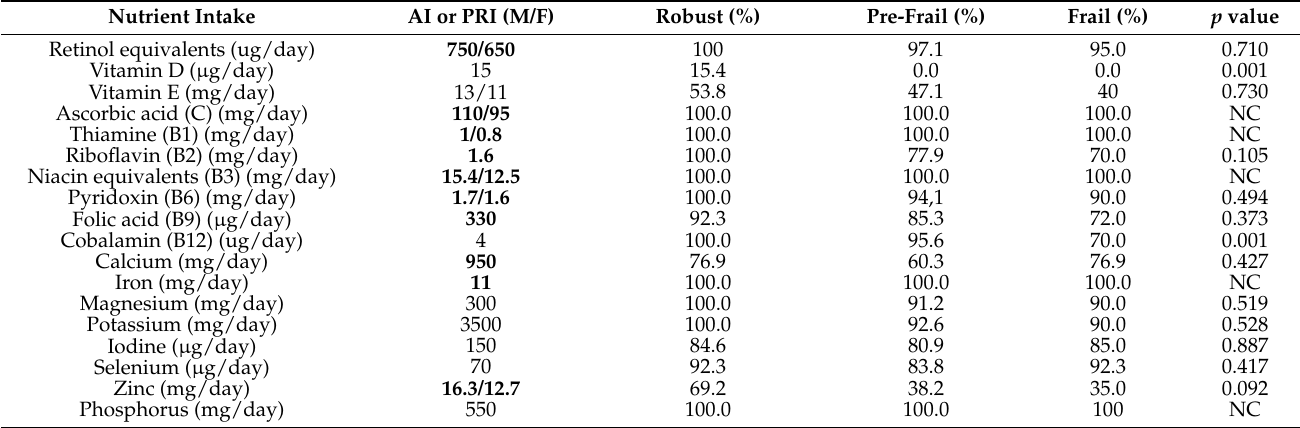
Table 3. Adequate intake or population reference intake and percentage of the sample covering recommendation from EFSA (European Food Safety Authority) of vitamins and minerals by Short Physical Performance Battery (SPPB) groups. Nutrient Intake AI or PRI (M/F) Robust (%) Pre-Frail (%) Retinol equivalents (ug/day) 750/650